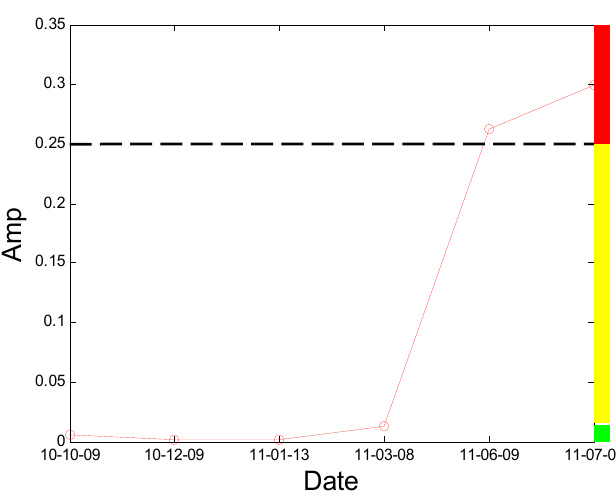
Figure 21. The result by the quantitative identification index of A fan No. 3H sensor.